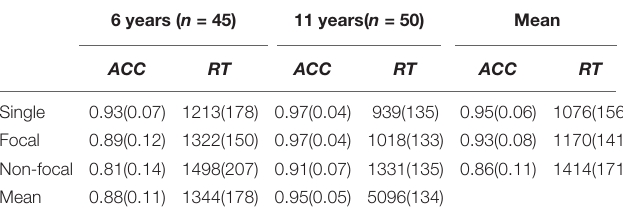
TABLE 1 | Means of the proportions of correct OT responses and reaction times (in